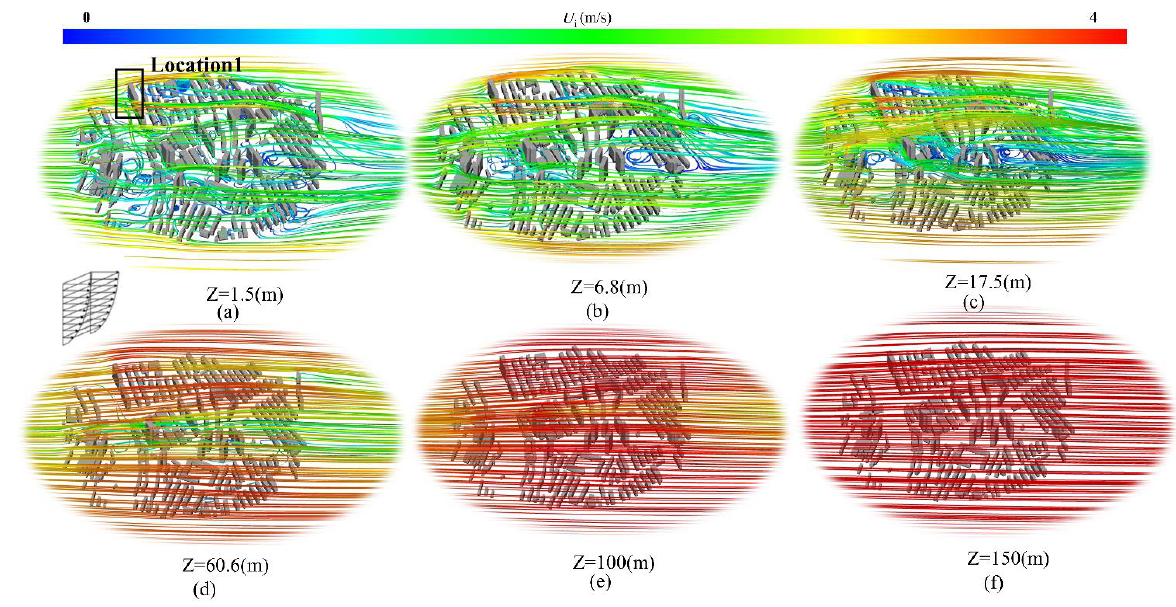
Figure 8. 3D streamline in street canyons.